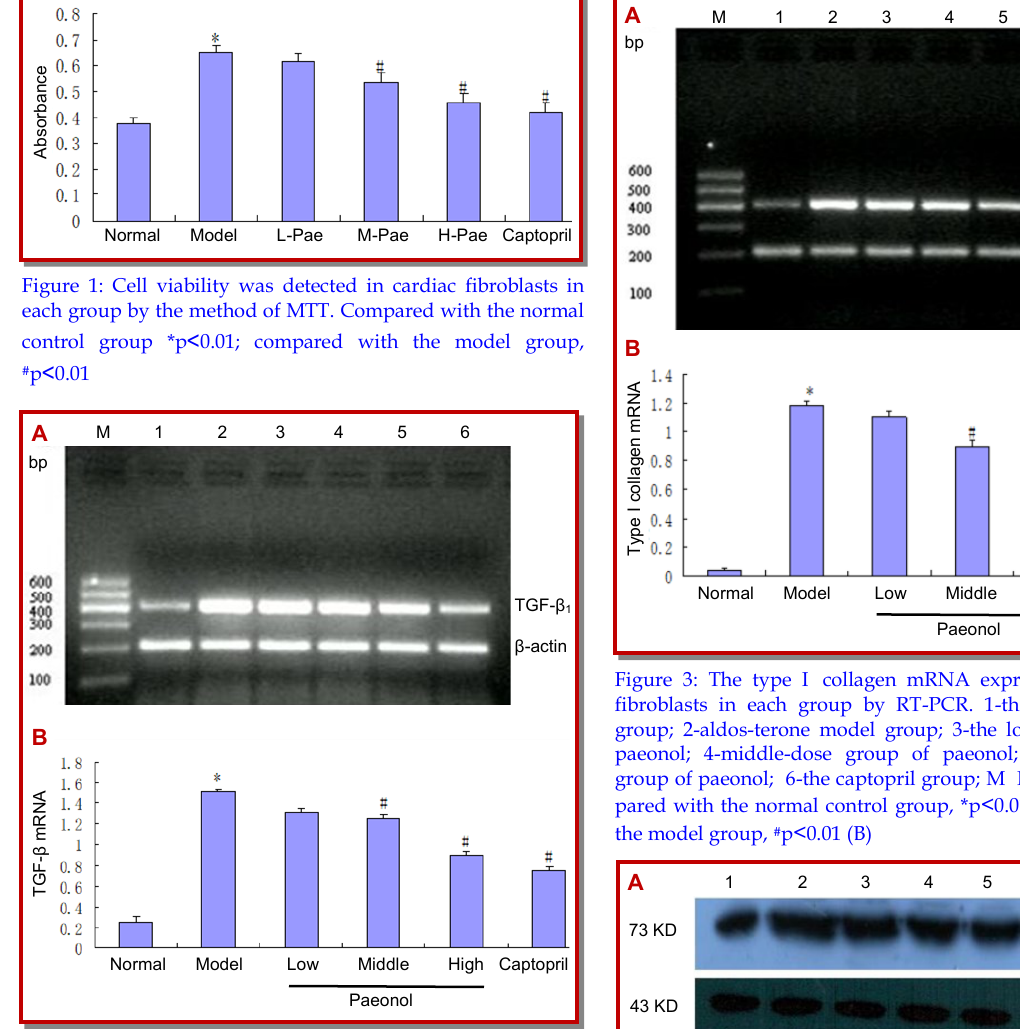
Figure 2: TGF- β1 mRNA expression of cardiac fibroblasts in each group by RT-PCR. 1-the normal control group; 2-the al- dosterone model group; 3-the low-dose group of paeonol; 4- the middle-dose group of paeonol; 5-the high-dose group of paeonol; 6-the captopril group; M Marker (A); Compared with the normal control group, *p < 0.01; compared with the model group, # p < 0.01 (B) band was observed between protein Marker 72 KD-95 KD. Western blot results showed that a β -actin band could be seen between protein Marker 34 KD-55 KD (Figure 4A). Compared with the normal control group, the expression of type III collagen in the model group was significantly enhanced (p<0.01). Compared with the model group, the expression of type III collagen in each dose group of paeonol was enhanced (p<0.01) in a dose-dependent manner with the increase of paeonol concentration. Compared with the low-dose group of paeonol, the expression of type III collagen was enhanced in the paeonol middle-dose group (p<0.01). Compared with the middle-dose group of paeonol, the expression of type III collagen was significantly